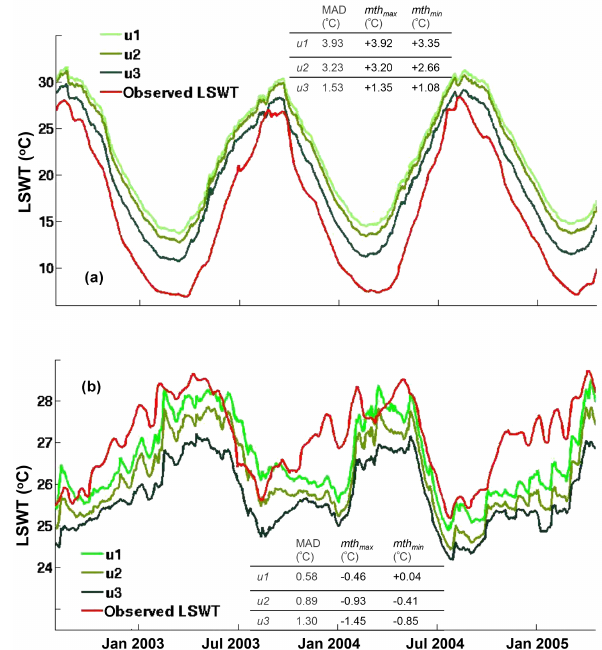
Figure 11. Effect of wind speed scaling on lake surface water tem- peratures (LSWTs) for a temperate non-ice-covered lake (a) Lake Biwa, Japan (36 ◦ N 136 ◦ E), and for a tropical non-ice-covered lake (b) Lake Turkana, Africa (4 ◦ N 36 ◦ E), showing that the mod- elled LSWT for the temperate lake is better represented using u 3 ( U water = 1 . 62ms − 1 + 1 . 17 U land ) , and the modelled LSWT for the tropical lake is better represented using u 1 (unscaled wind speed). mth min (and mth max ) is the difference between the observed and modelled LSWTs for the month where the minimum (and max- imum) LSWT is